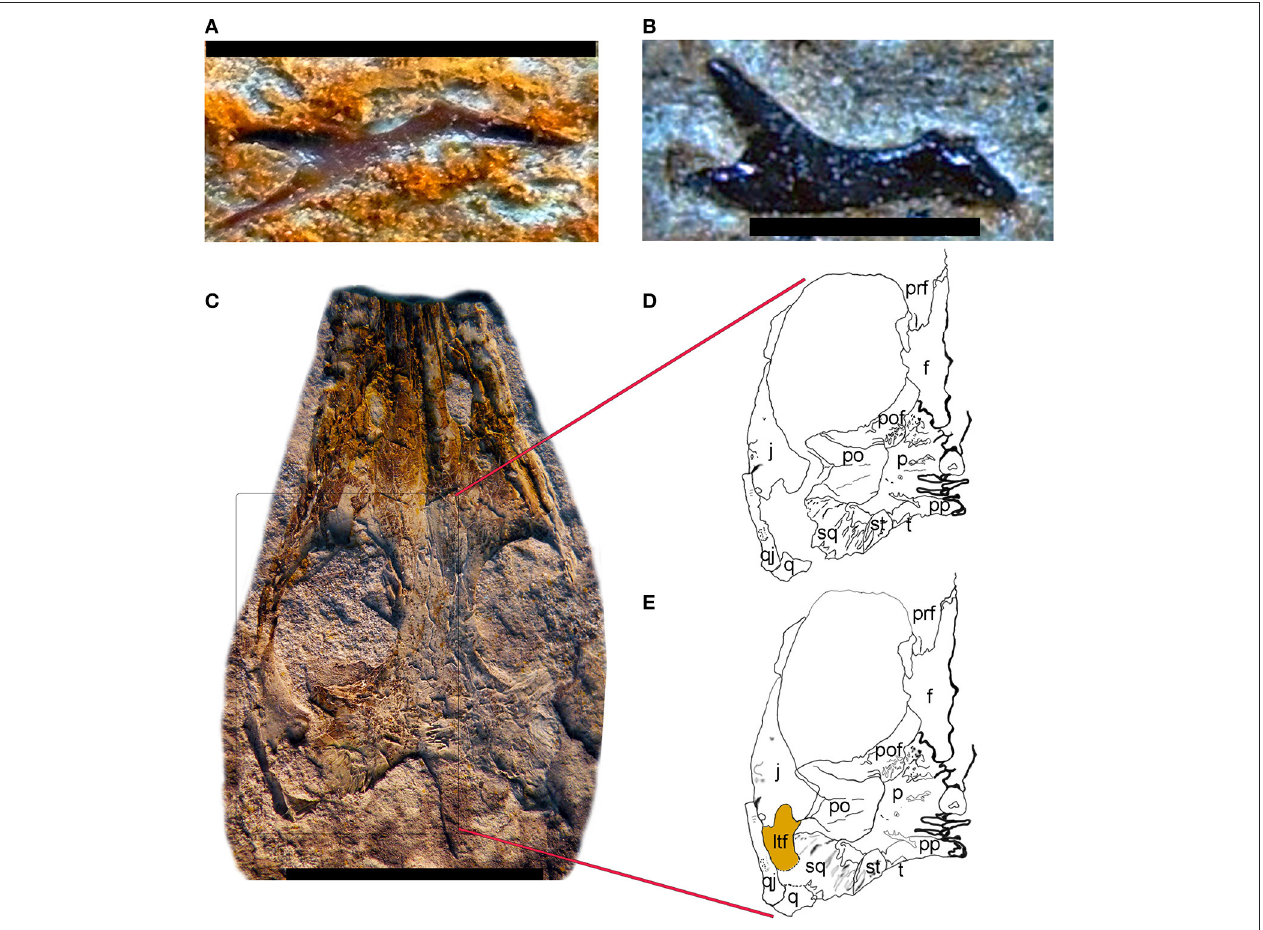
FIGURE 1 | Mesosaur lateral temporal fenestra. (A) FC-DPV 1462, right jugal, probably of a newborn individual showing the typical triradiate structure normally associated with a temporal fenestra. (B) FC-DPV 1083, right jugal of a juvenile individual showing the same typical triradiate structure. (C) FC-DPV 2534B, partial skull of an adult Mesosaurus tenuidens showing a well-preserved temporal region. Some of the bones that delimit the lateral temporal fenestra (jugal and quadratojugal) are partly disarticulated. However, the jugal displays the typical triradiate structure commonly associated with the presence of a temporal fenestra. (D) Schematic drawing of the FC-DPV 2534B left postorbital region as it was preserved, showing the jugal and quadratojugal partially disarticulated. (E) Schematic reconstruction of the possible natural anatomical configuration of the FC-DPV 2534B left postorbital region. The jugal-postorbital contact and the position of the quadratojugal relative to the jugal are approximate given that the skull bones were compressed by sediment deposition, disrupting their original three dimensional arrangement. However, the proposed configuration is the most plausible one given the morphology observed in other specimens, and the general anatomy of the bones in question. Scale: (A,B) 5mm; (C)